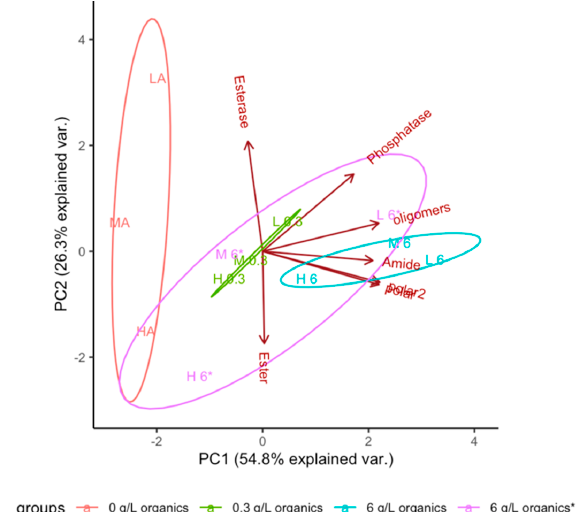
Figure 3. PCA of evolved soups grouped by rehydration solution. Samples rehydrated with ultrapure water (A, 0 g/L organics) are in red; samples rehydrated with 200-fold diluted soup (0.3 g/L organics) are in green; samples rehydrated with 10-fold diluted soup (6 g/L organics) are in cyan; samples rehydrated with 10-fold diluted soup containing 35 g/L sea salt (6*, 6 g/L organics*) are in purple. Starting salinity indicated with L, M, or H (as in Figure 1). All sample pH values were prepared and maintained between 2 and 3.